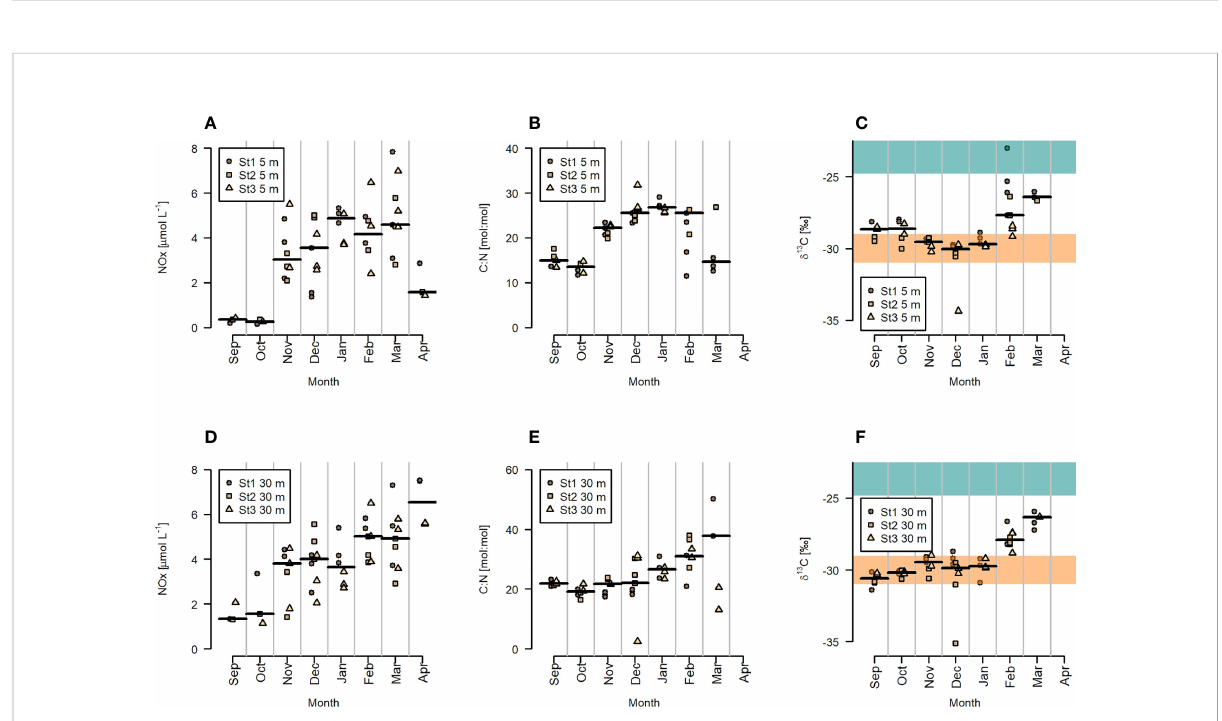
FIGURE 4 Biogeochemical indicators with dissolved inorganic NO X (A, D) and molar C:N ratios (B, E) as proxies for the nutritional state and d 13 C- POC (C, F) as proxy for the origin of organic particulate matter. Plots (A – C) show data for 5 m depth and plots (D – F) data for 30 m depth. Horizontal black lines show the median of all data of the month, and different symbols indicate the individual data for the three stations. Terrestrial d 13 C-POC values reported by Simenstad and Wissmar (1985) are marked in orange, coastal phytoplankton d 13 C-POC values reported by Simenstad and Wissmar (1985) are marked in